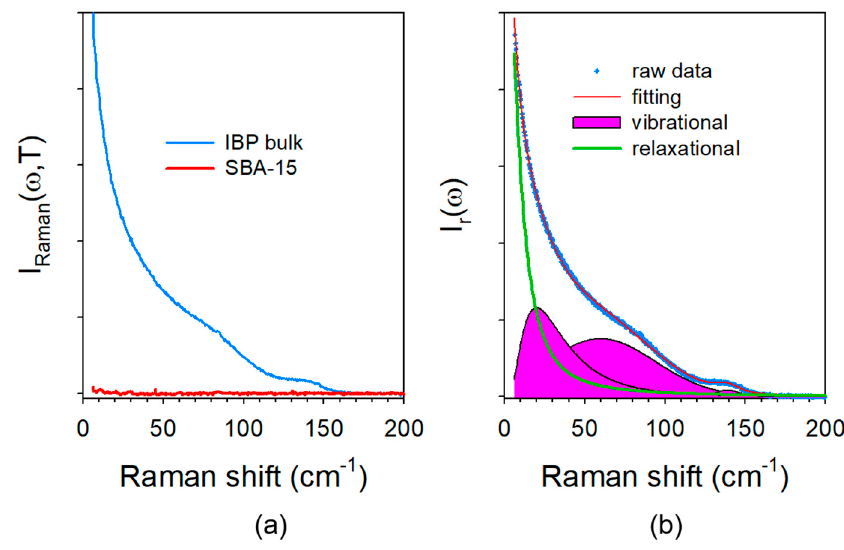
Figure 2. Low-frequency spectrum of IBP at room temperature; ( a ) Raman intensity of the under- cooled liquid bulk of IBP compared with the spectrum of SBA-15; ( b ) fitting procedure of the reduced intensity used for discriminating the contributions of relaxational and vibrational motions .